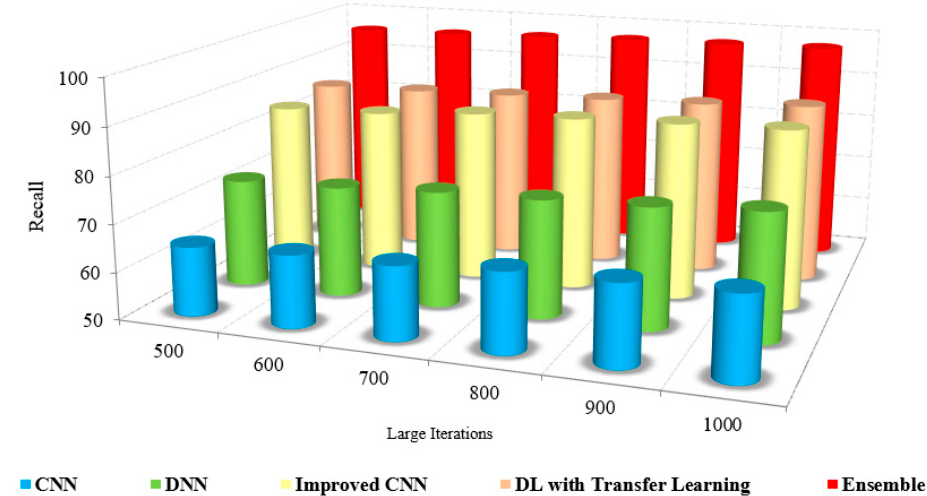
Figure 11. Large Iteration count vs. recall.